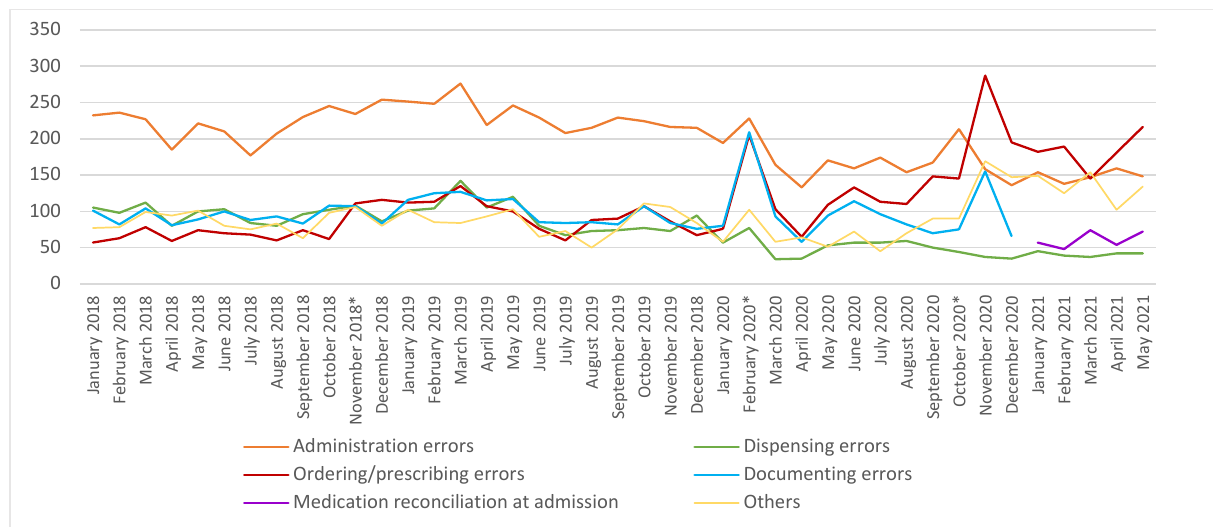
Figure 1. Trends in all reported MEs and MEs which reached patients during 1/2018–5/2021. * Different implantation phases (Go-Lives = GLs) GL1: 11/2018, GL2.1: 2/2020 and G 2.2. 10/2020.